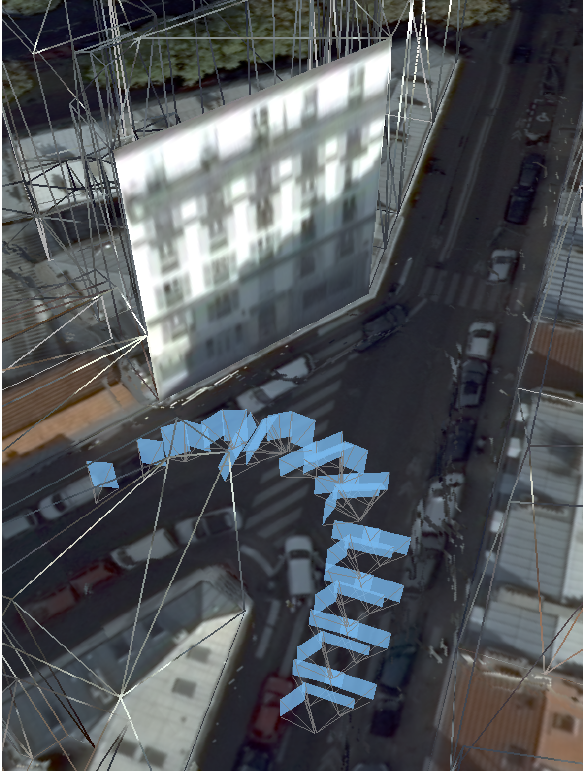
Figure 2: Set of images selected by our method as containing pertinent information about a facade (non